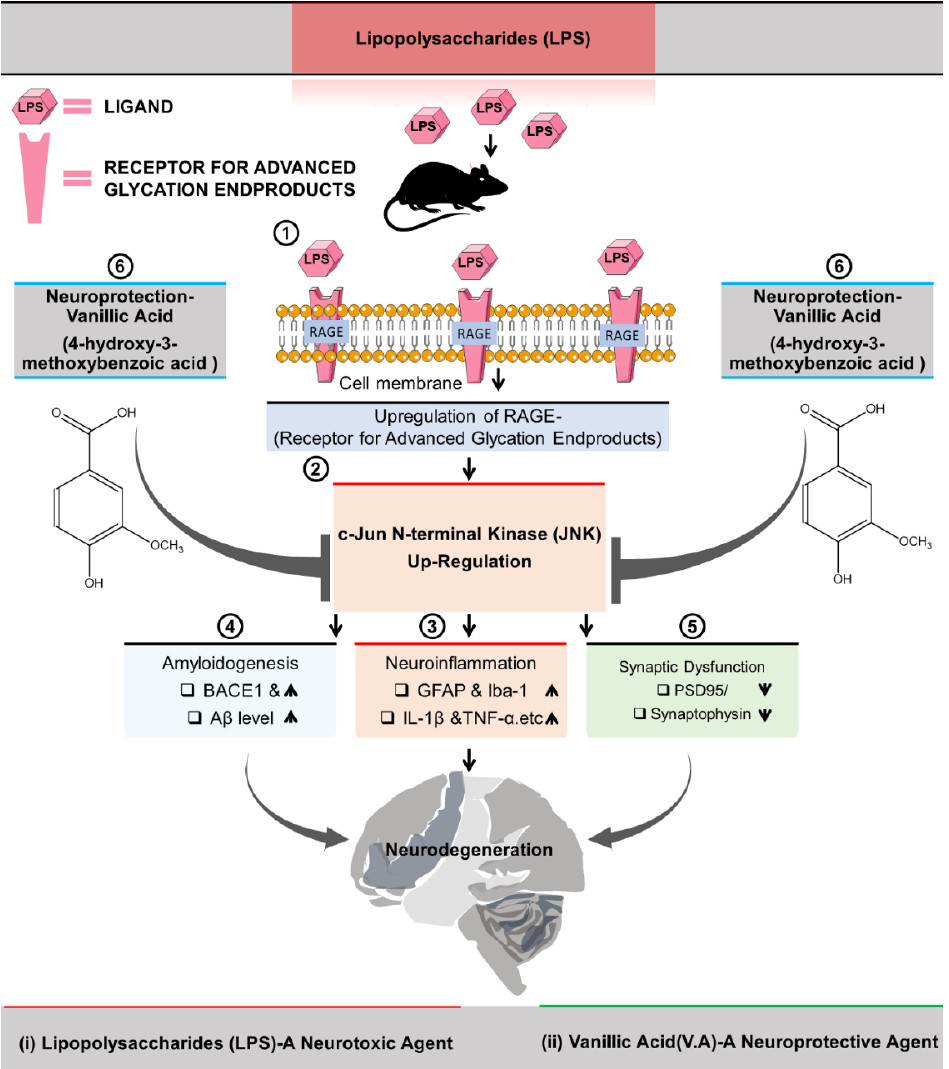
Figure 6. Suggested graphical representation of neuroprotective mechanism of vanillic acid against LPS-induced neurotoxicity in mice brain. LPS (intraperitoneal injections (I.P.) 250 μg/kg/day) via RAGE result in neurodegeneration. in this process, LPS-activated p-JNK has a central role in activating various downstream signaling cascades lea ding to neuroinflammation: Resulting from increased in expression level of p-NF-κB, TNFα, IL-1β, and COX-2. amyloidogenesis: Resulting from increased in expression level BACE-1 and Aβ. Synaptic dysfunction: Resulting from reduction in the expression level of synaptic makers (PSD-95, SYP). vanillic acid (I.P. 30 mg/kg) reduced LPS-induced neurotoxicity might via inhibition of LPS/RAGE-mediated elevated c-Jun N-terminal kinase in mice brain.